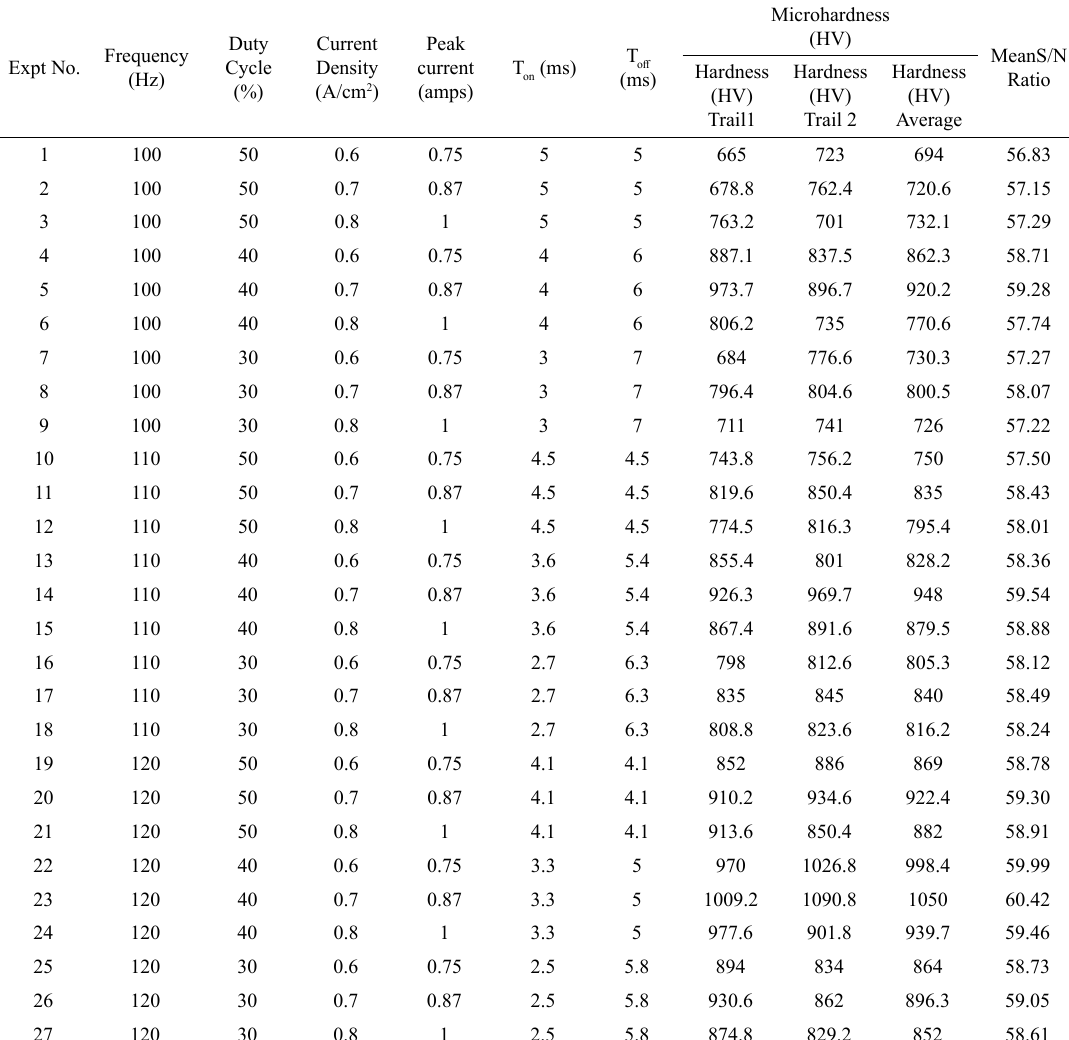
Table 4. Experimental results for microhardness and S/N